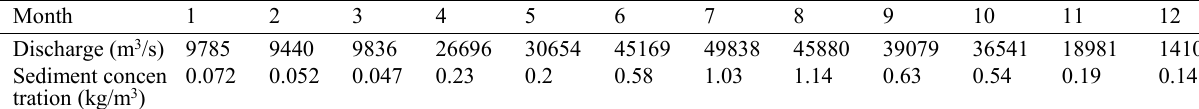
Table 1 Monthly discharges and sediment concentrations for one hydrodynamic year.